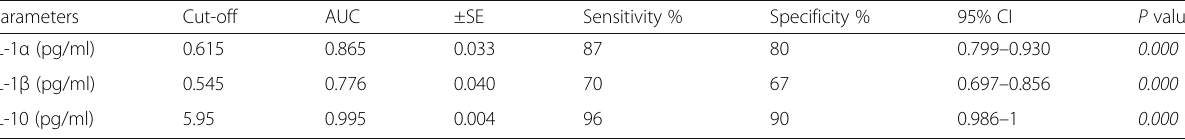
Table 4 ROC analysis of inflammatory cytokines in T1DM and controls